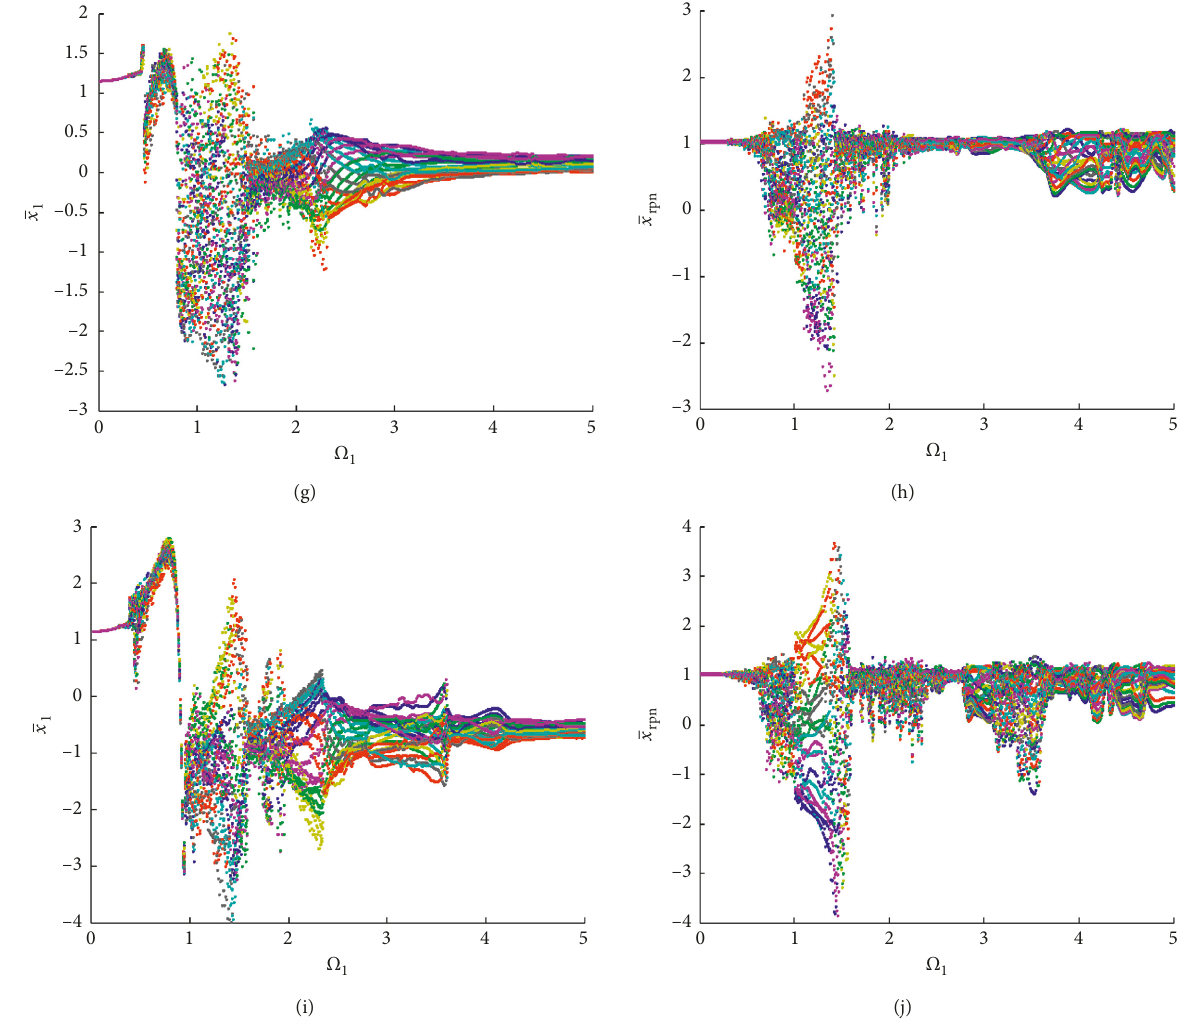
Figure 2: Bifurcation diagrams of the system with fixed-axis wear fault: (a) and (b) e e � e � 0.4; (g) and (h) e a1 a2